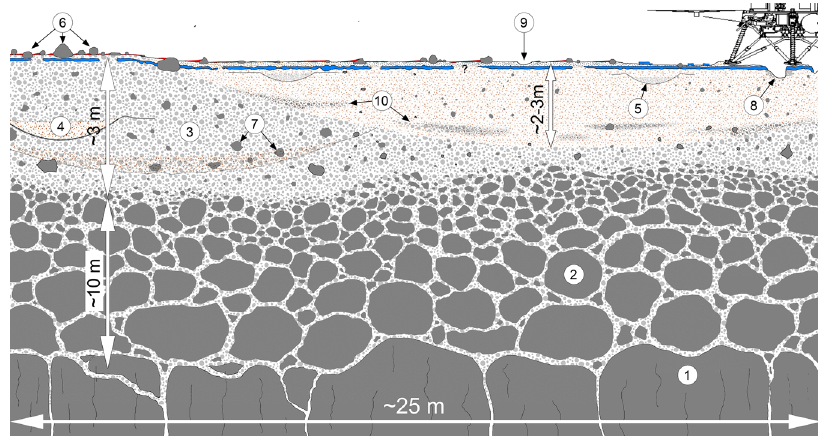
Fig. 9 Interpretive cross section of the shallow subsurface beneath the InSight lander. Most of the sur fi cial bright, reddish dust (red, shown behind some rocks) has been dispersed around the lander (above 8). Rockier areas beyond ~20 m have more surface dust (6). The dust, which settled out of the atmosphere, is likely microns thick. About 1 cm of unconsolidated sand indicated by the radial surface striations and surface divots (9) underlies the dust. Observed in the pits beneath the lander (8) and in the mole hole is a duricrust of cemented sand, pebbles and rocks that is 5 – 10 cm thick (shown in blue), but could vary in thickness. Beneath the duricrust are overlapping craters (4, 5), rocks (7), and lens of ejecta from other craters (10). The relatively fi ne- grained impact generated regolith (3) is around 3 m thick beneath the lander and likely grades with depth into coarse, blocky ejecta (2) that overlies fractured basalt fl ows (1). Observations from the lander described in the text support the top 10 cm of the cross section. The bottom 13 m of the cross section are derived from estimates of the thickness of the relatively fi ne-grained regolith from rocky and non-rocky ejecta craters 2,3,18 and the original depth of the Homestead hollow crater. Note the varying vertical